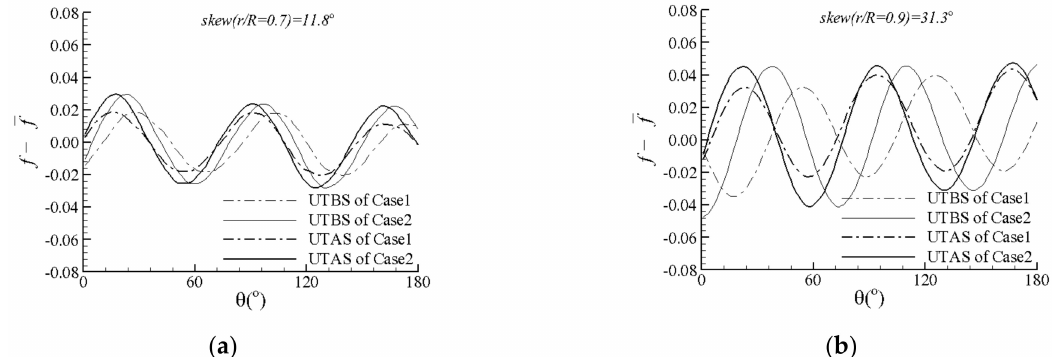
Figure 4. Unsteady thrust before shift (UTBS) and unsteady thrust after shift (UTAS) of Case 1 and Case 2 at ( a ) r / R = 0.7 and ( b ) r / R = 0.9.